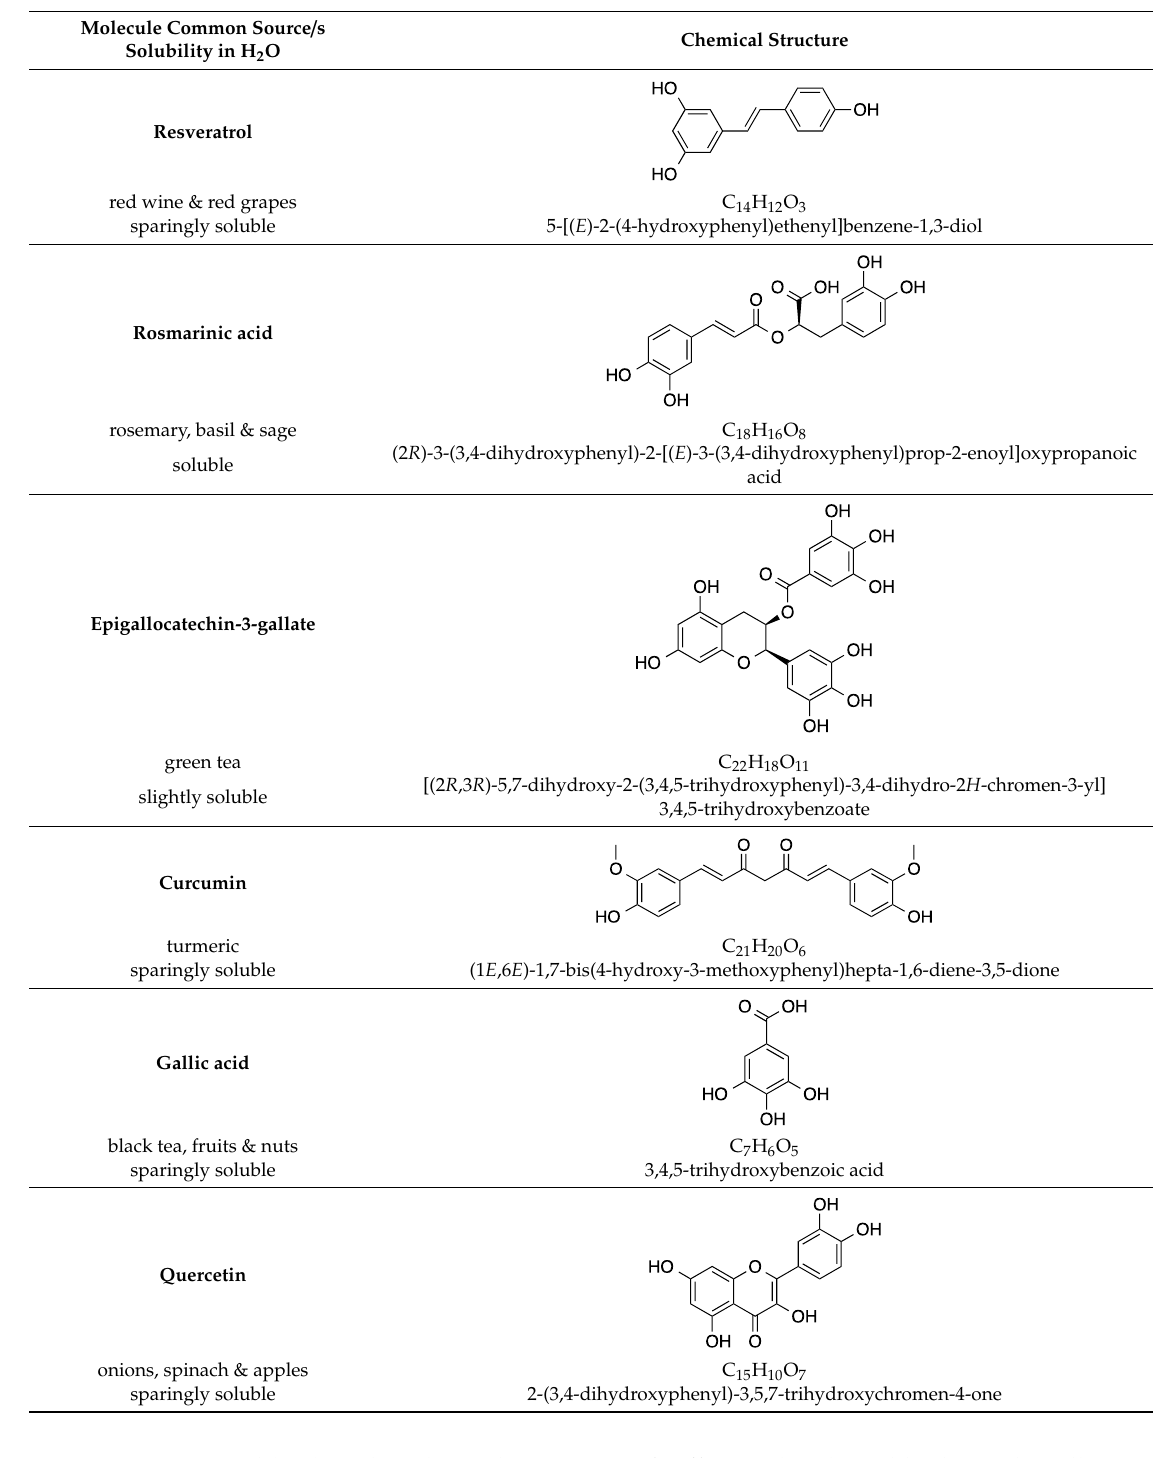
Figure 1. Isomers of resveratrol. Trans-resveratrol is more stable than cis-resveratrol and accounts for the beneficial effects of the polyphenol. Table 1. Structures, common sources and water solubility of polyphenols in this review.